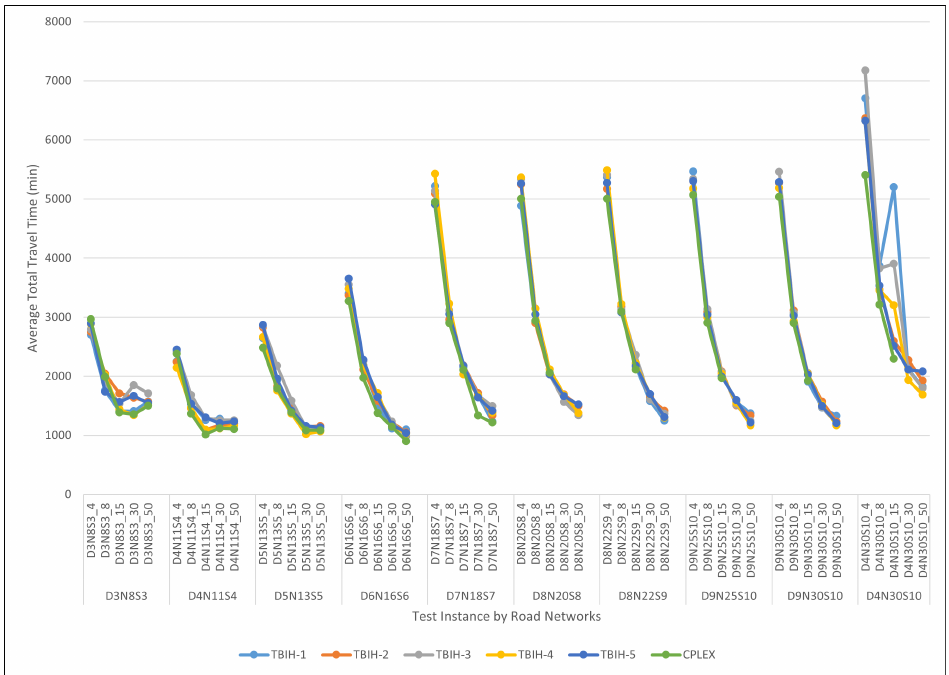
Figure A17. Algorithms performance compared to matheuristic rollout applied in PDS-RA: best total travel time (min) measured based on test